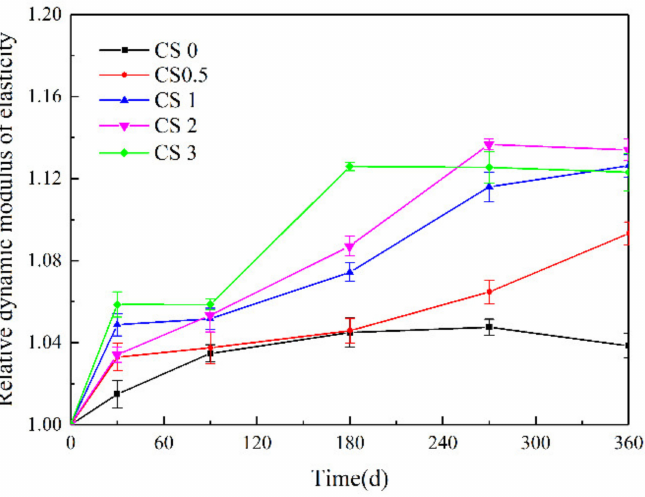
Figure 6. Relative dynamic modulus of elasticity of concrete specimens against corrosion